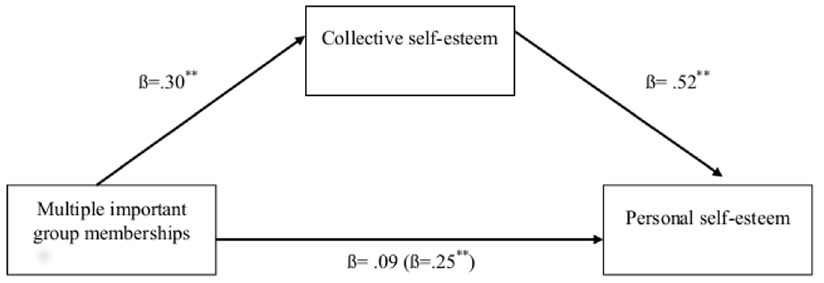
Fig 2. Study 4: The indirect effect of collective self-esteem on the relationship between multiple group memberships and personal self-esteem for University students in the US. Note . ** p < .001. Correlations were based on a sample of N = 302. Beta within parentheses represents the direct